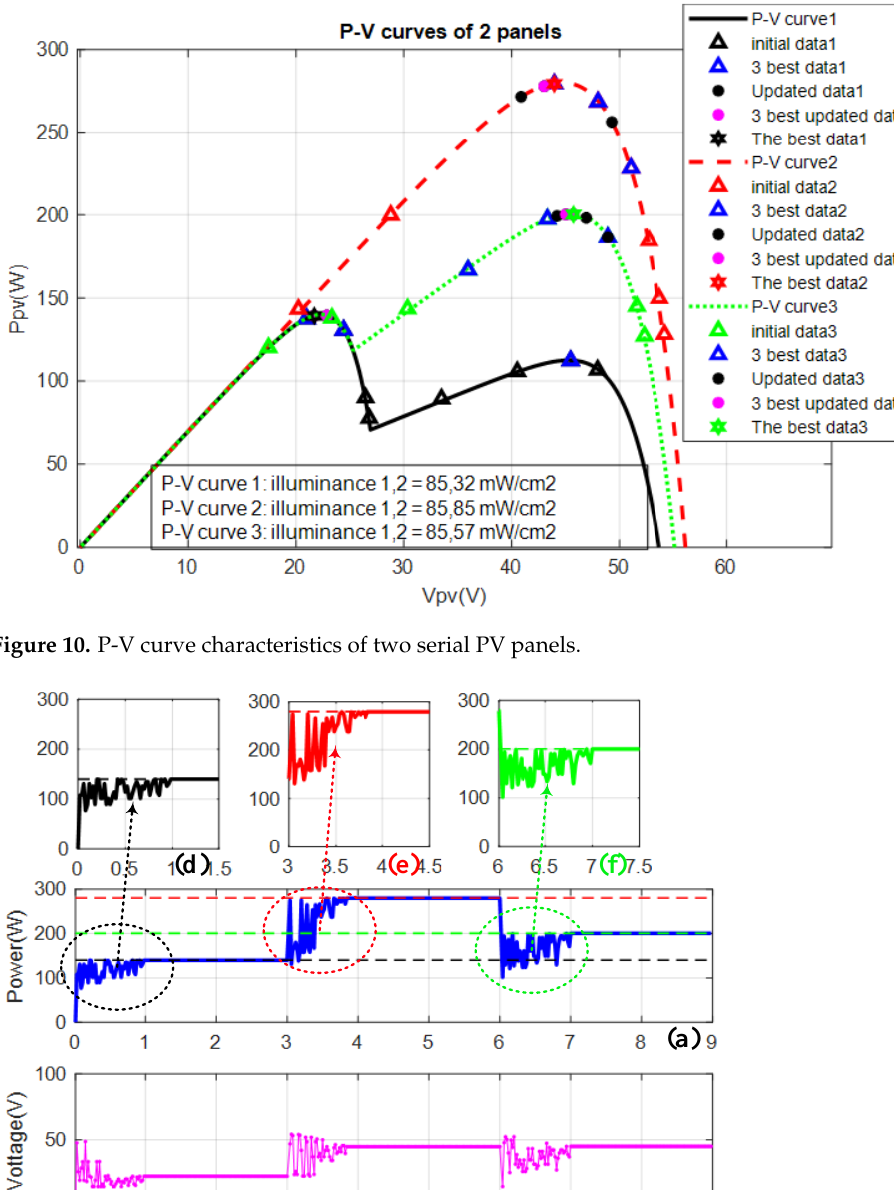
Figure 12. Results of the GWA method for two serial panels. ( a ) PV power, ( b ) PV voltage, ( c ) duty ratio, and ( d – f ) transient trajectories for situations 1 – 3, respectively. (Black --, red --, green --: global maximum values of situations 1 – 3).